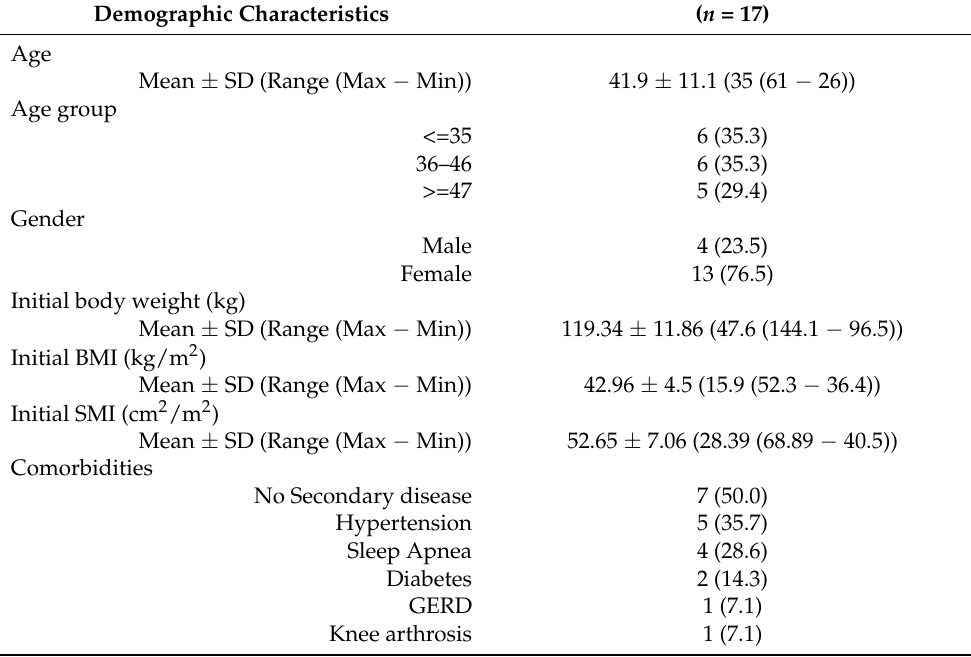
Table 1. Demographic characteristics of the